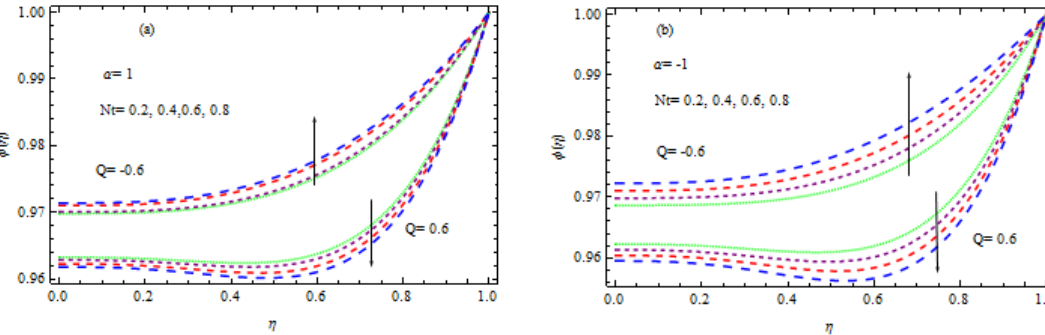
Figure 16. ( a , b ) Influence of Nt on temperature.